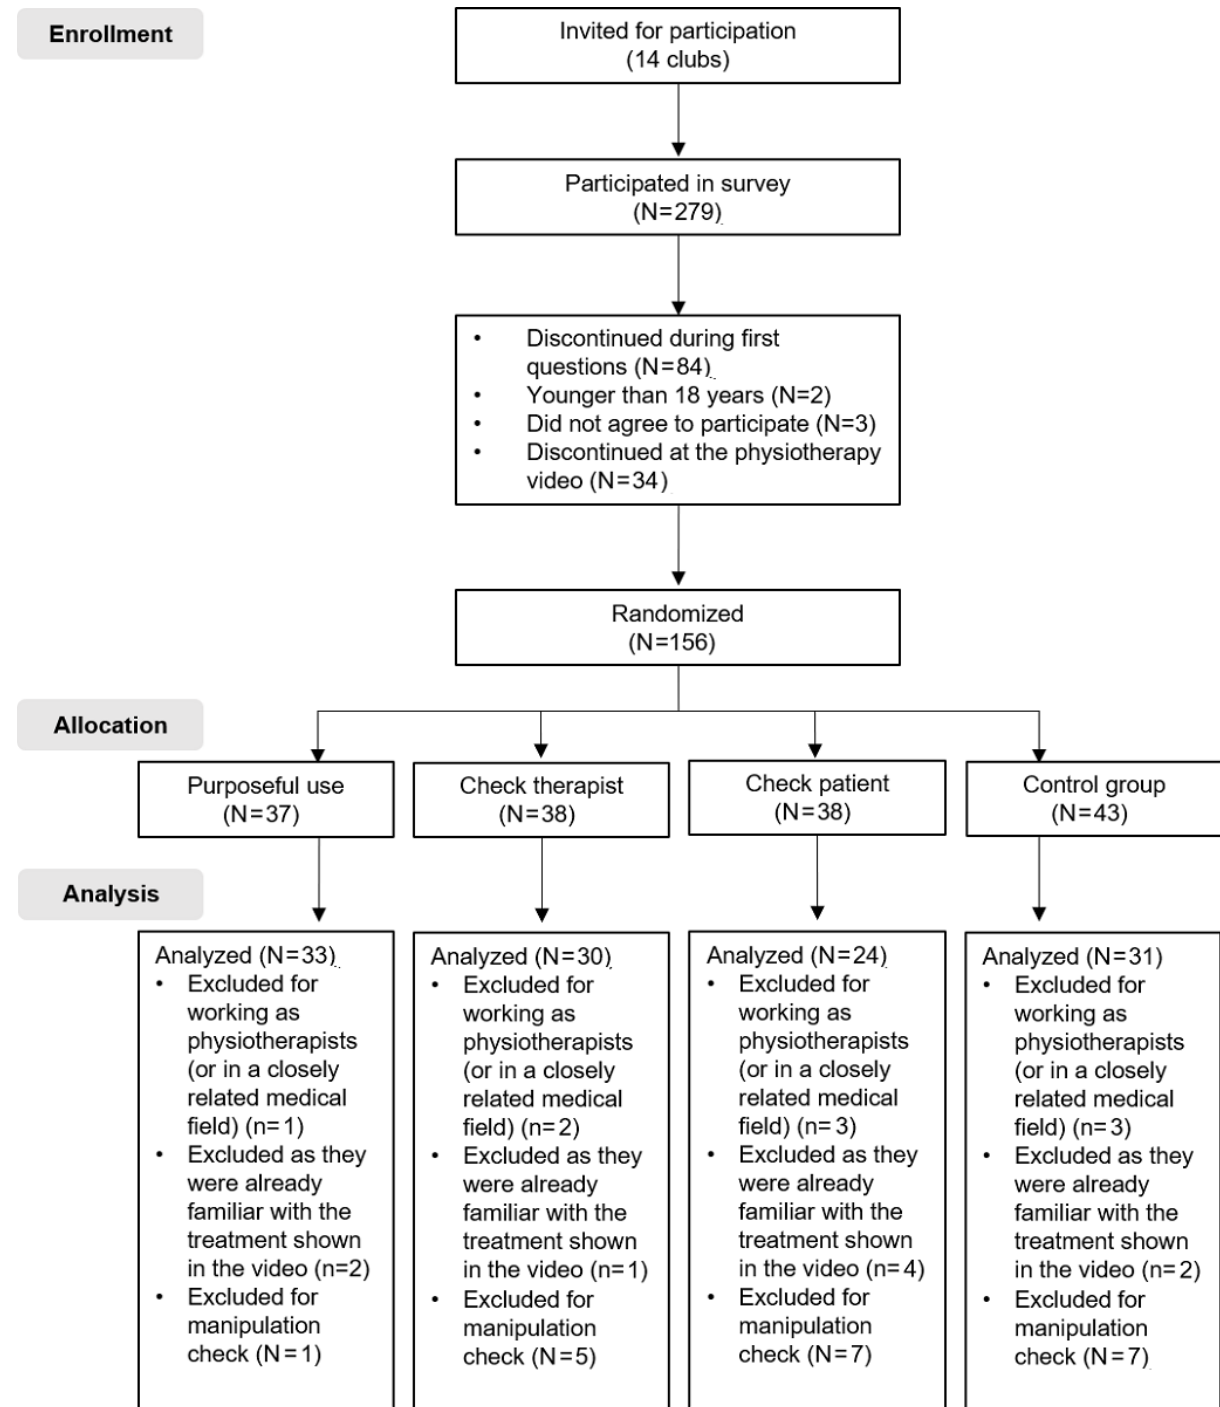
Figure 2. Flow diagram for study